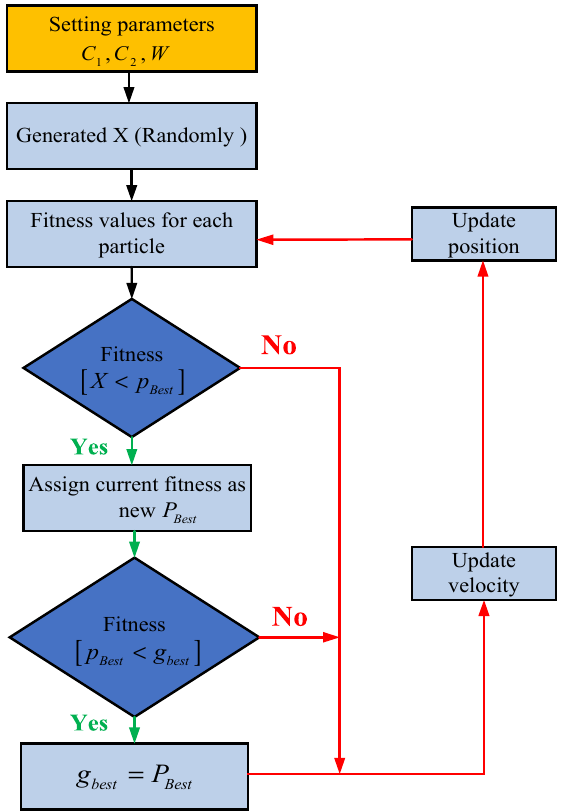
Figure 6. Schematic diagram of the particle swarm optimization process.